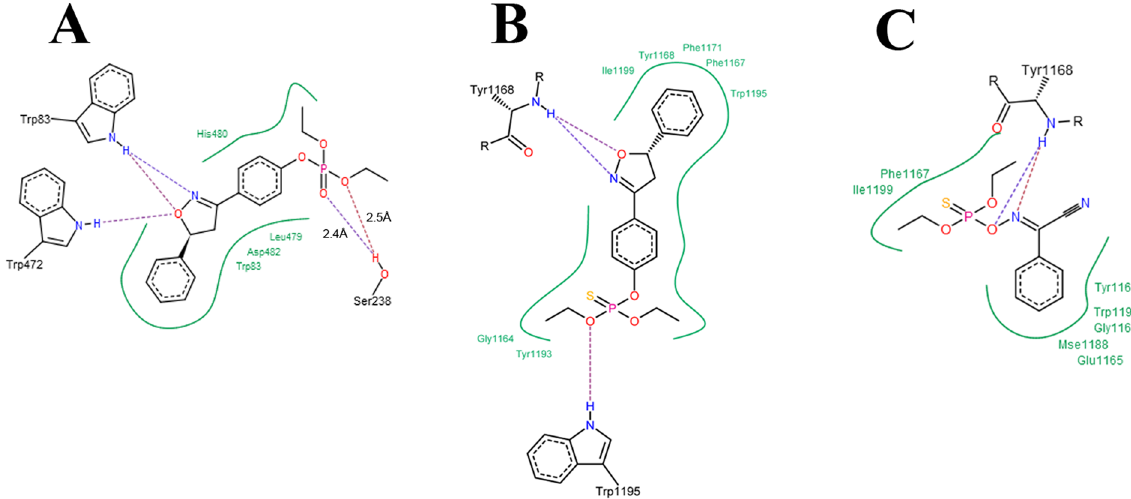
Figure 3. The 2D interaction modes of XP-1408 and phoxim within the binding site of corresponding LBD. ( A ) Docking model of oxidative desulfurated XP-1408 combined with AChE. ( B ) Interaction mode of XP-1408 with Na v channel. ( C ) Interaction mode of phoxim with Na v